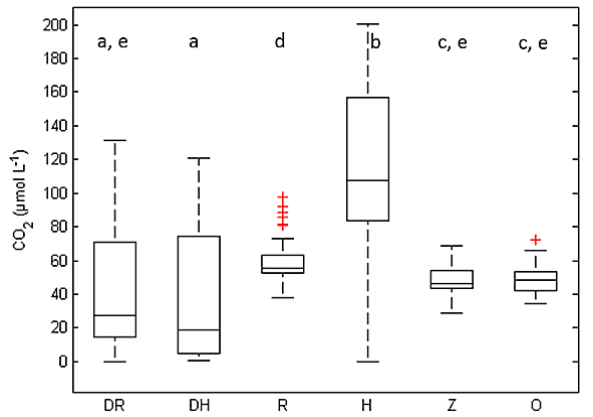
Fig. 2. Boxplots describing the yearly CO 2 concentration (µmolL − 1 ) in the investigated streams (Rappbode (R, n = 52), Hassel (H, n = 53), Zillierbach (Z, n = 59), Ochsenbach (O, n = 47)) and the pre-dams (Rappbode (DR, n = 14), Hassel (DH, n = 14)). The following parameters are displayed: medians, quartiles, whiskers and outliers. The letters a, b, c, d and e indicate the signif- icance of differences between groups ( p < 0 . 05).